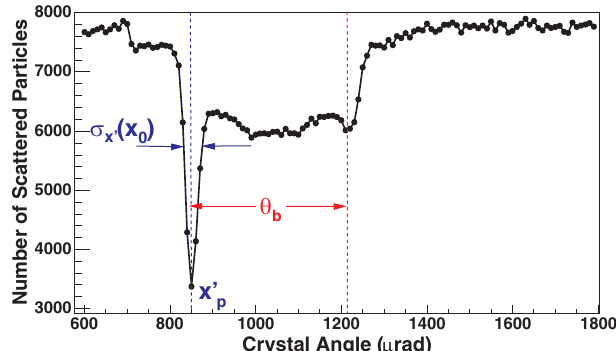
FIG. 4. (Color) Simulation of the number of scattered particles as the crystal angle is changed. A reduction in the scattering rate indicates channeling. The crystal is properly aligned at x 0 830 (cid:2) rad . This is a different simulation than Fig.